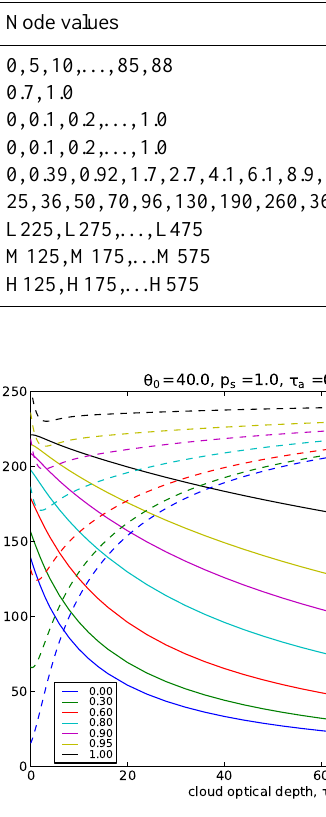
Figure 4. Typical dependence of the AVHRR/3 channel 1 re- flectance on cloud optical depth for different surface albedos (solid lines, left y axis) together with the derivative (dashed lines, right y axis) indicating the change in the reflectance for a unit change in the cloud optical depth. Symbols are defined in Table 2.